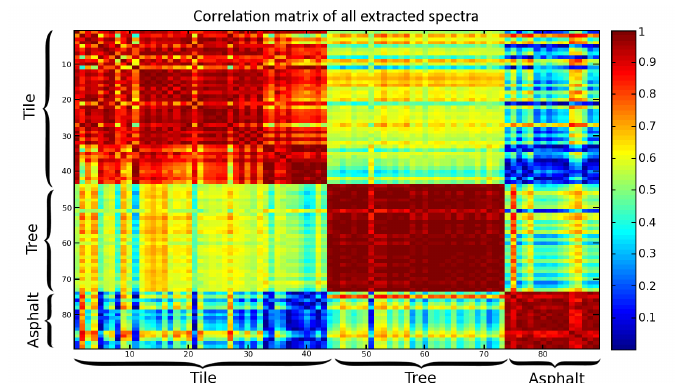
Figure 4. Correlation matrix of all extracted